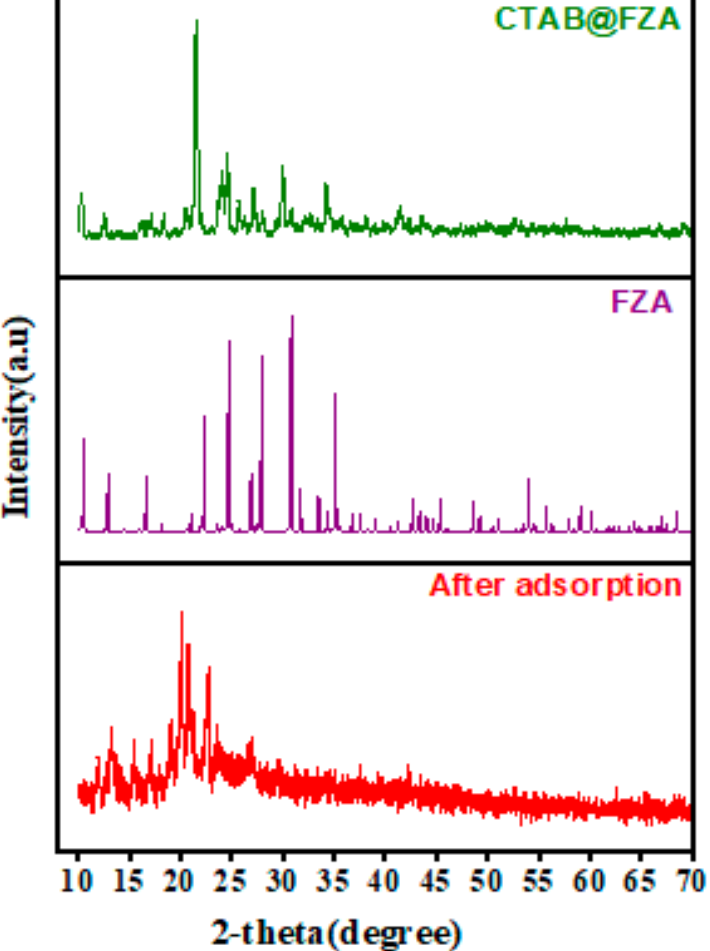
Figure 2. XRD spectra of FZA@CTAB ( top ), FZA ( middle ), and after Cr(VI) adsorption of CTAB@FZA ( bottom ).